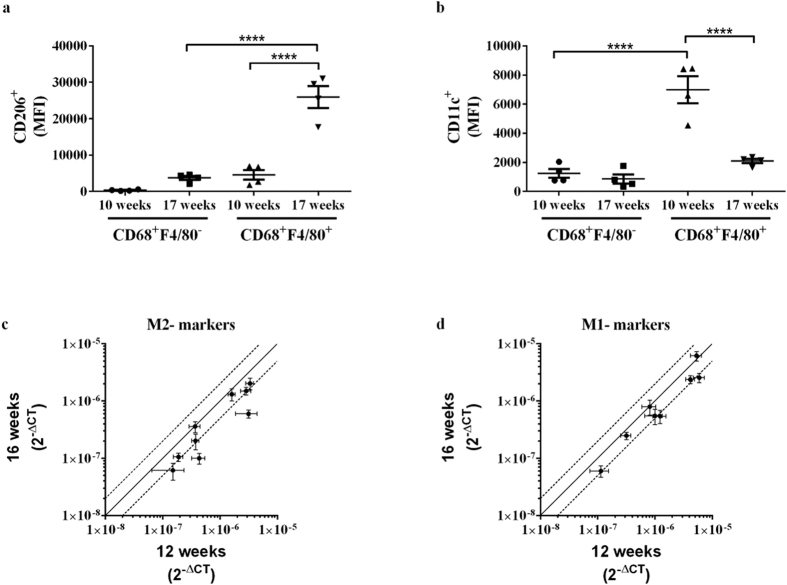
Macrophage polarisation in whole aortas and isolated lesion areas from ApoE−/− mice.(a,b) Flow cytometry of whole aortas to detect CD206 (a) and CD11c (b) expression (MFI: mean fluorescent intensity) in CD68+F4/80− and CD68+F4/80+ cells after 10 or 17 weeks on WD (n = 4 mice/time point). *p < 0.05, ****p < 0.0001 as determined by 1-way ANOVA with Tukey’s post-test. See Suppl. Fig. 3 for representative MFI histograms. (c,d) mRNA expression levels (2−ΔCT) of M2 (c) or M1 markers (d) in aortic lesion areas isolated after 12 or 16 weeks of WD (n = 7 mice/group). Each point represents expression level (2−ΔCT) of a given gene. The full line indicates genes, where the expression level is the same, while data points placed above or below the dotted lines are more than 2 fold up- or down-regulated, respectively, after 16 compared to 12 weeks of WD. The specific genes of interest, their fold change and statistics can be found in Suppl. Table 2.